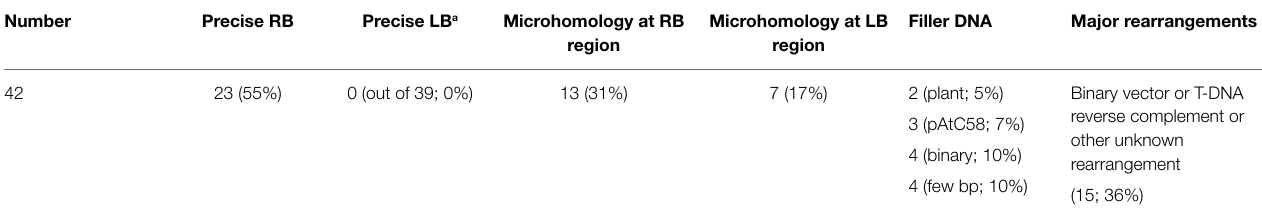
TABLE 5 | Summary of properties of T-circles from Nicotiana benthamiana generated by pE4636. Number